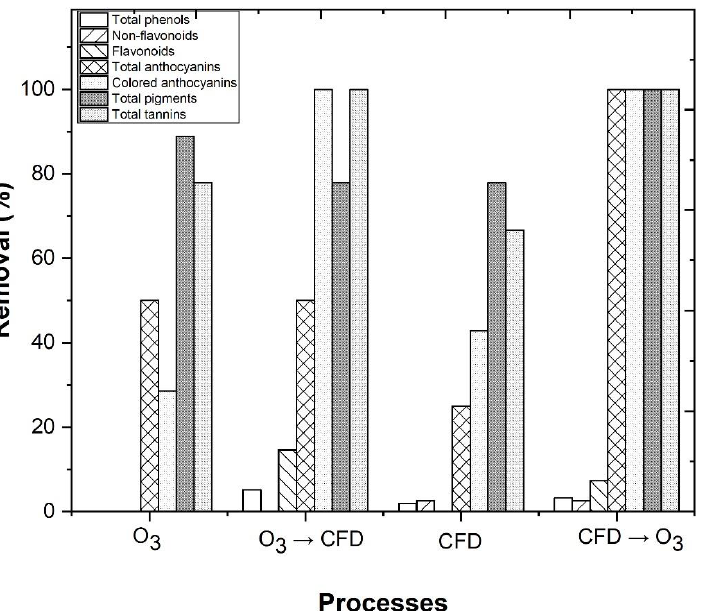
Figure 12. Analysis of total phenols, non-flavonoids, flavonoids, total anthocyanins, colored anthocyanins, total pigments and total tannins removal. The following CFD operational conditions: 0.48 g/L potassium caseinate, 0.52 g/L bentonite, pH 4.0, temperature 298 K, rapid mix 150 rpm/3 min, slow mix 20 rpm/20 min, sedimentation time 12 h. The following O 3 /Fe 2+ /UV-C experimental conditions: pH = 4.0, [Fe 2+ ] = 1.0 mM, ozone flow rate 5 mg/min, air flow 1.0 L/min, agitation 350 rpm, time 600 min and a UV-C mercury lamp (254 nm).